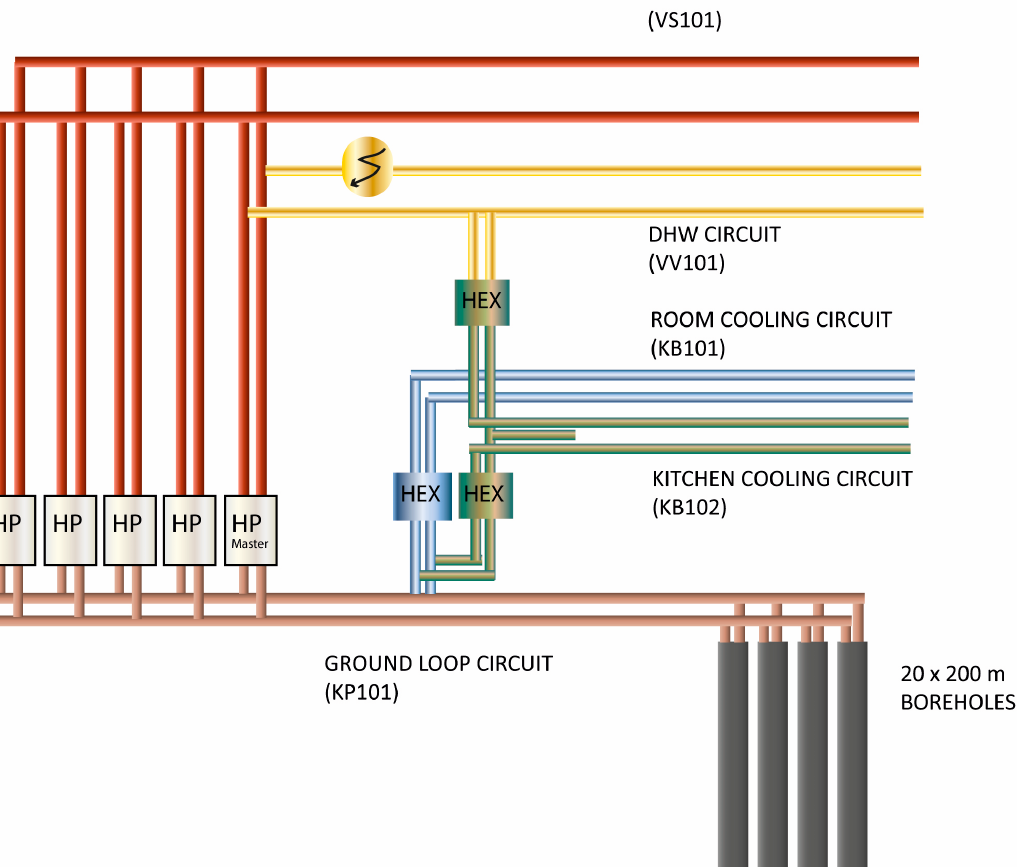
Figure 2. Schematic of the Studenthuset heating and cooling system. Illustration by S. Gehlin.